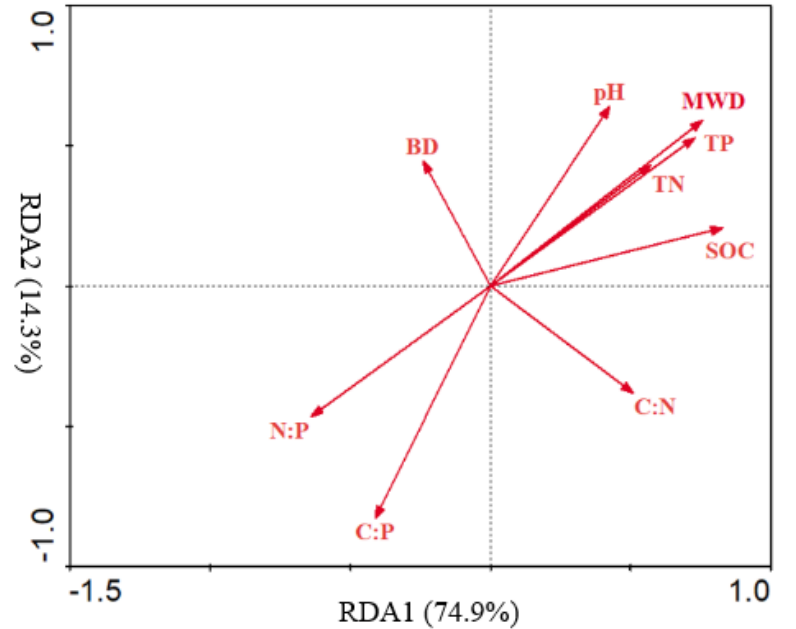
Figure 6. Redundancy analysis (RDA) between MWD and soil physicochemical factors. MWD: mean weight diameter. Soil physicochemical factors include SOC (soil organic carbon), TN (total nitrogen), TP (total phosphorus), C:N (SOC/TN), C:P (SOC/TP), N:P (TN/TP), pH, and BD (bulk density).